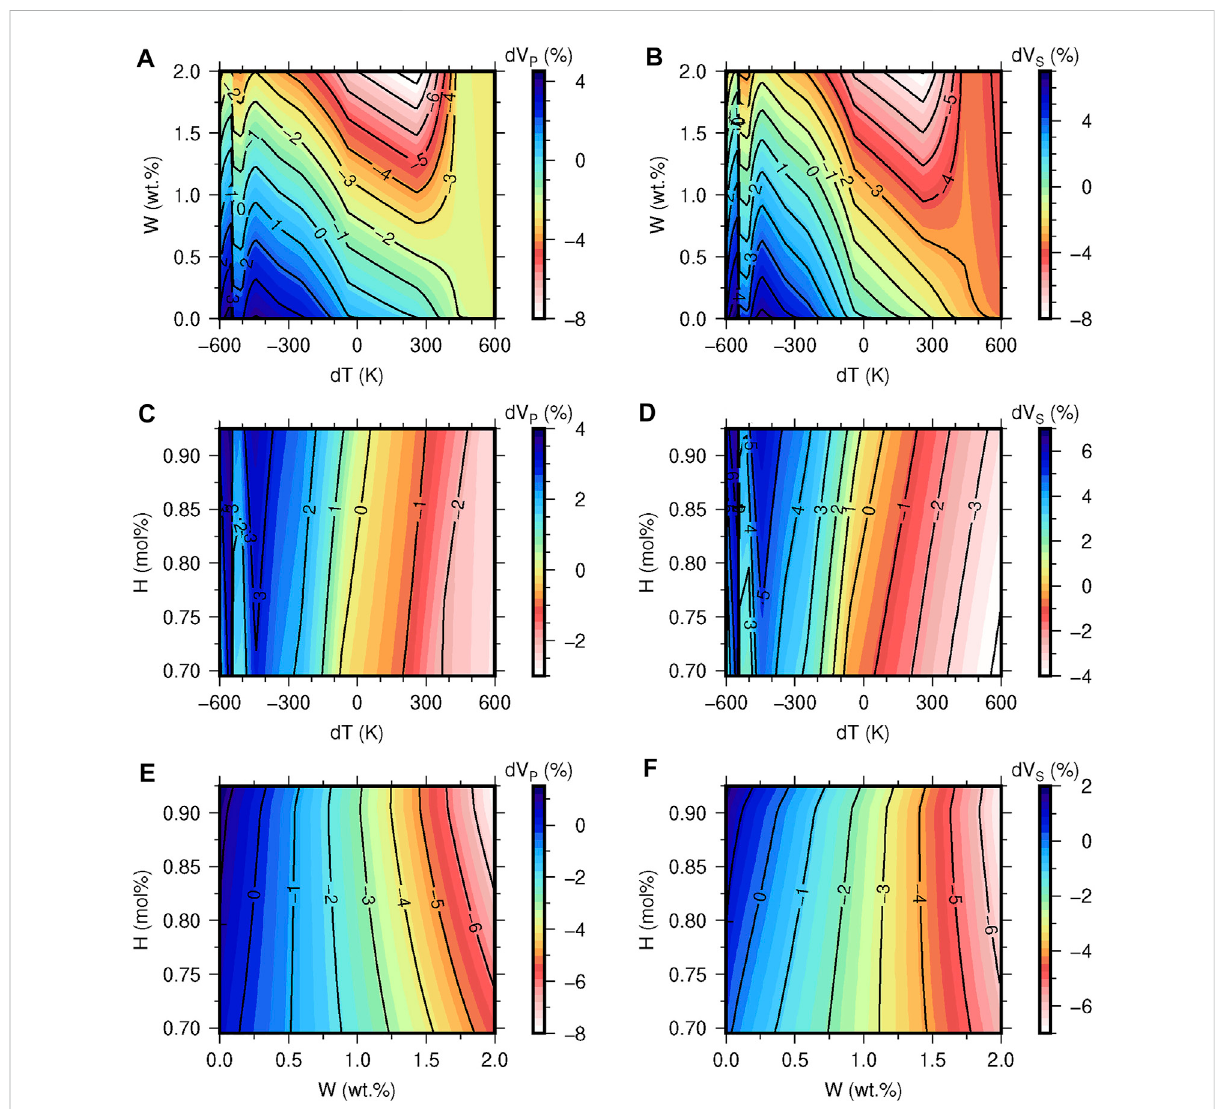
FIGURE 3 The sensitivity kernels of P- and S-wave velocity anomalies in the lower MTZ to water and temperature based on the pyrolite composition model (A,B) ; to temperature and harzburgite abundance based on a water content of 0.25 wt% in ringwoodite (C,D) ; to water and harzburgite abundance based on the 1,400 ° C adiabatic geotherm (E,F)